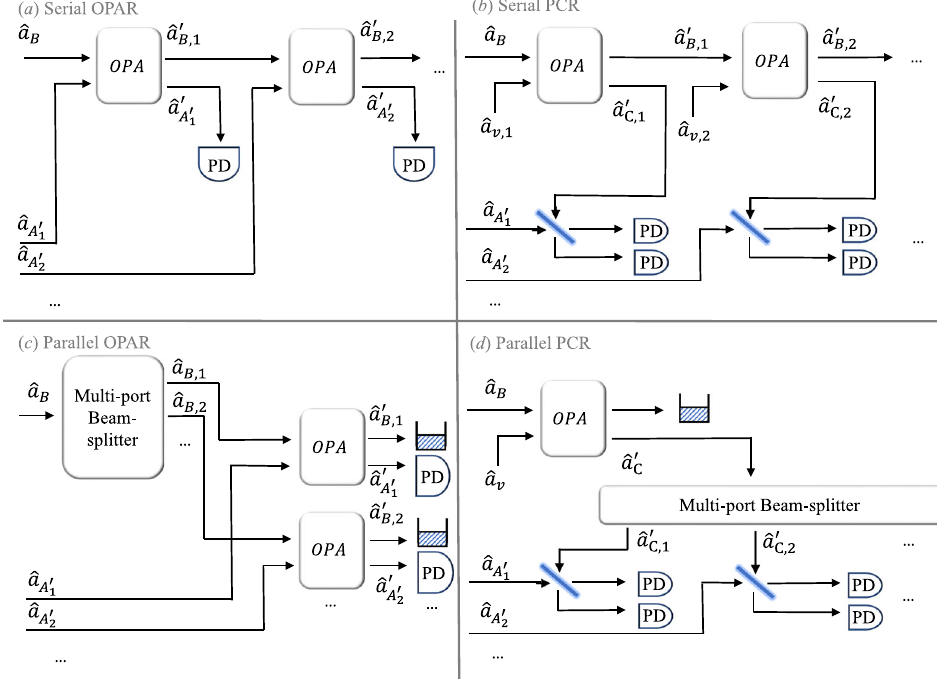
Fig. 7 Schematics of four receiver designs. a serial optical-parametric-ampli fi er receiver (sOPAR), b serial phase-conjugate receiver (sPCR), c parallel optical-parametric-ampli fi er receiver (pOPAR), d parallel phase-conjugate receiver